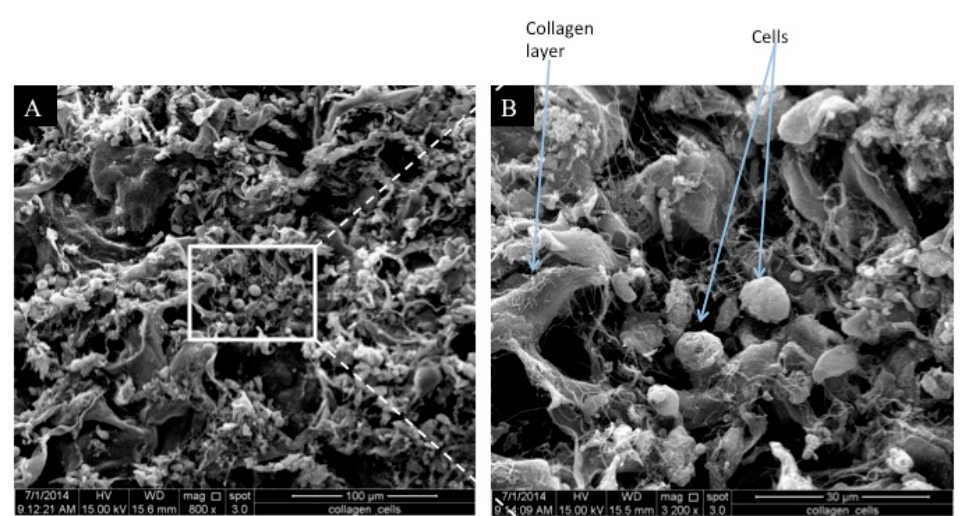
Figure 4. The top view of the cell-seeded collagen scaffold immunostained with ( A ) anti-Col type I antibody (green) as the fibroblast marker and ( B ) anti-cytokeratin 14 antibody (red) as the marker of RECs. ( C ). The cell nuclei were counter-stained with 4`,6-diamidino-2-phenylindole (DAPI) (blue). ( D ) Merged image 10× and ( E ) 20×. ( A ). The anti-Col type I antibody was found to bind to the scaffold in addition to the fibroblasts. The intense green color located almost centrally ( A ) formed due to the accumulation of green fluorescence in unknown debris.